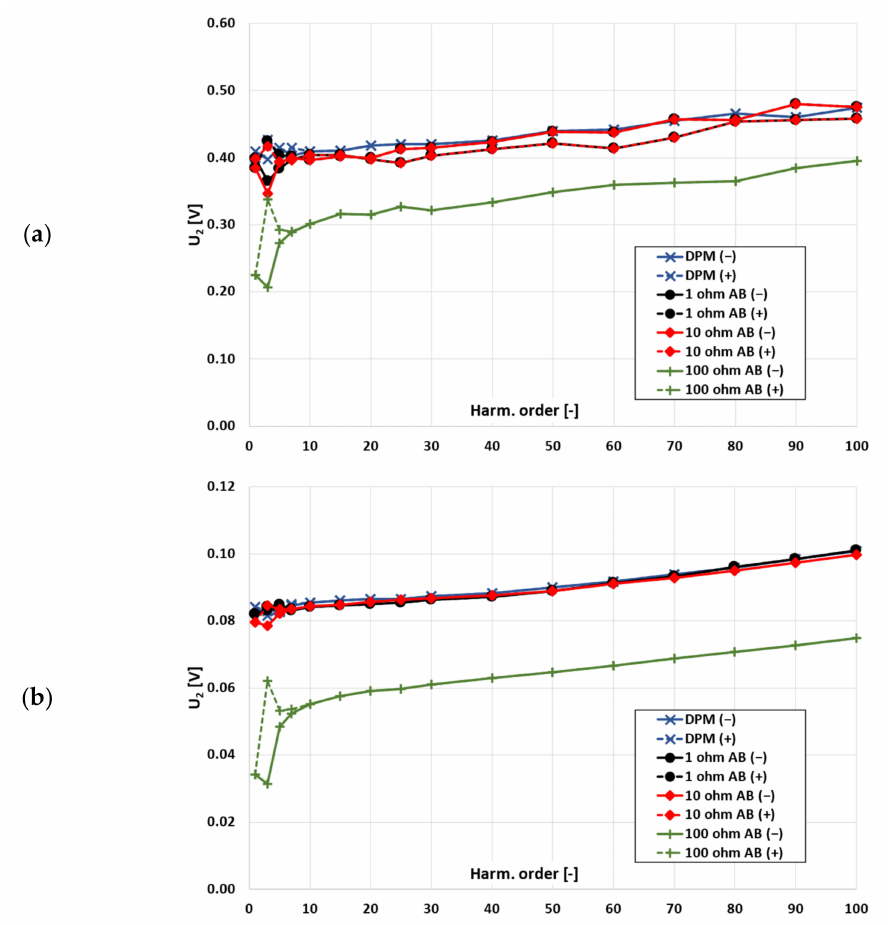
Figure 4. The dependence of secondary voltage of the tested CT from the voltage drop on the current shunt for different values of its resistance (used notations are as in Figure 3) for two values of the primary current ( a ) 100%, ( b )